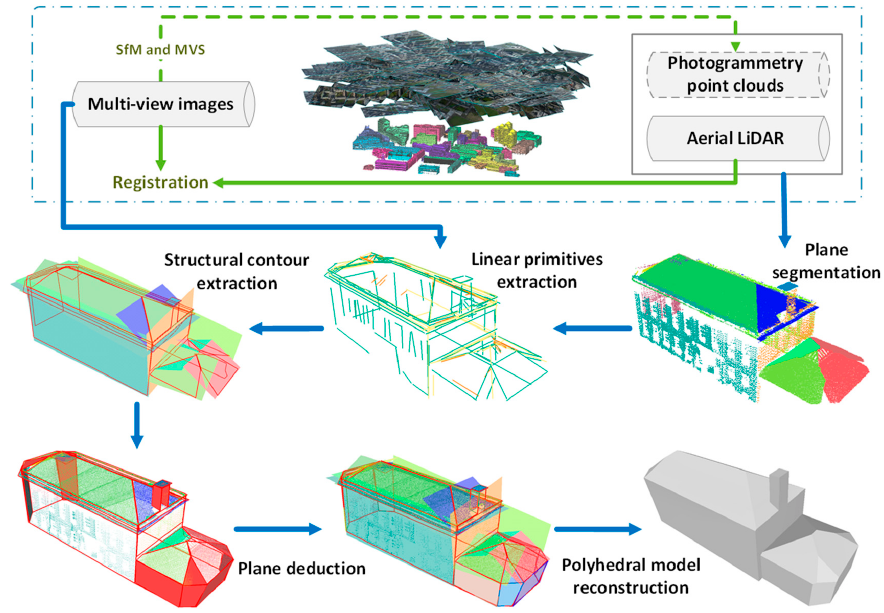
Figure 2. The pipeline of the LoD3 building reconstruction from point clouds.